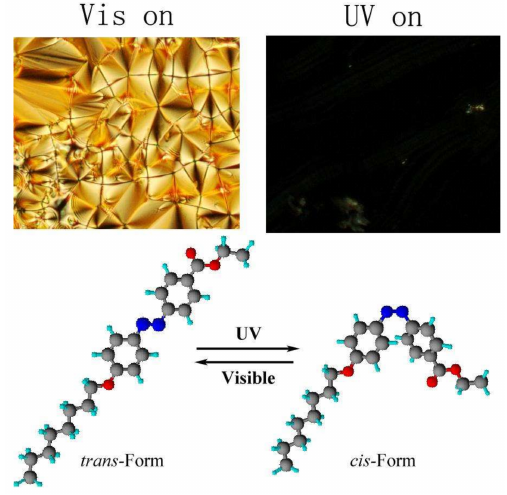
Figure 6. UV-induced trans – cis isomerization of compounds 2c (POM, 200 × magnification), space filling model drawn by 3D-ChemDraw.